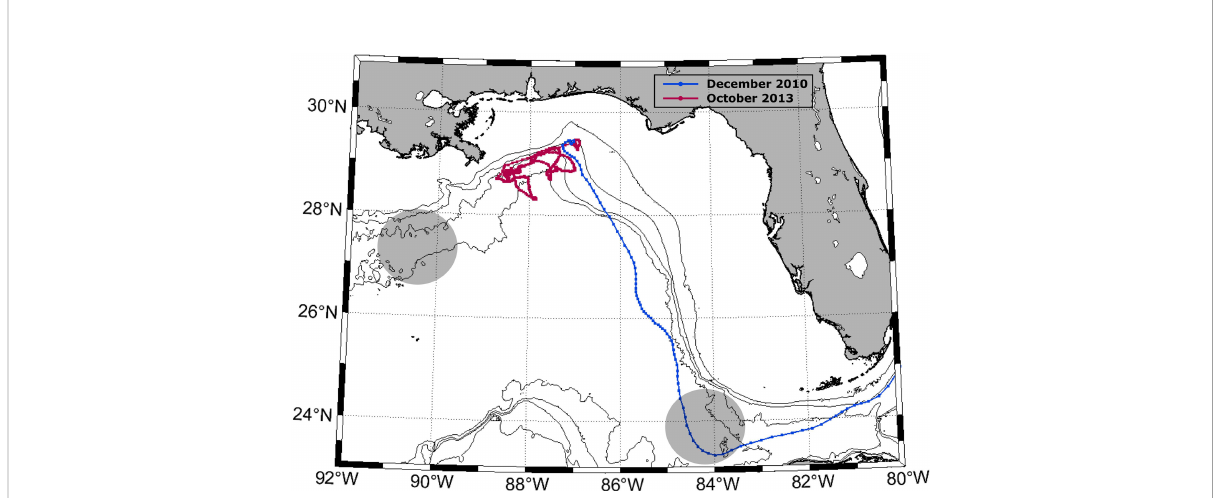
FIGURE 14 Example virtual particle tracks for times with reduced (blue) and increased (red) eddy activity in the northeastern GoM. Gray-shaded areas located at the western edge of the Florida Straits and southwest of Mississippi Canyon denote particle exit points into the Atlantic and western GoM, respectively. Isobaths and coastlines are shown in